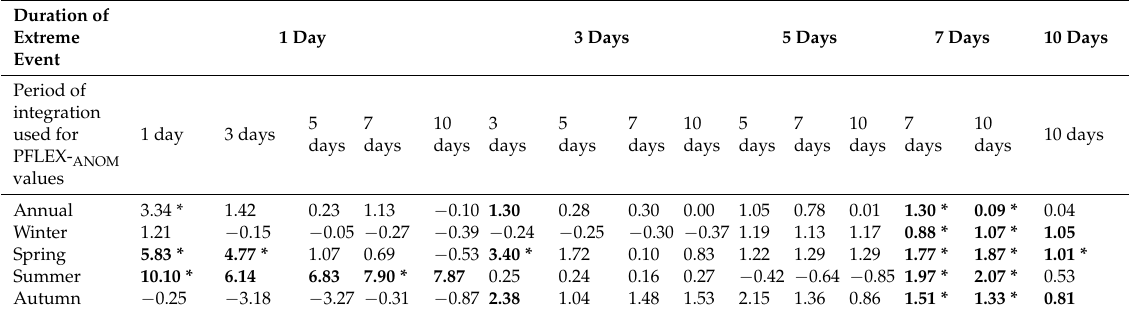
Table 4. Slope values of simple linear regression analysis between CHIRPS anomaly values of extreme precipitation for events with different durations (1, 3, 5, 7, and 10 days) with respect to PFLEX- ANOM values (for 1, 3, 5, 7, and 10 integrated days) on annual, winter, spring, summer, and autumn scales. Highlighted numbers represent those values that are significant at 90% when applying Student’s t -test, and the asterisk denotes 99%